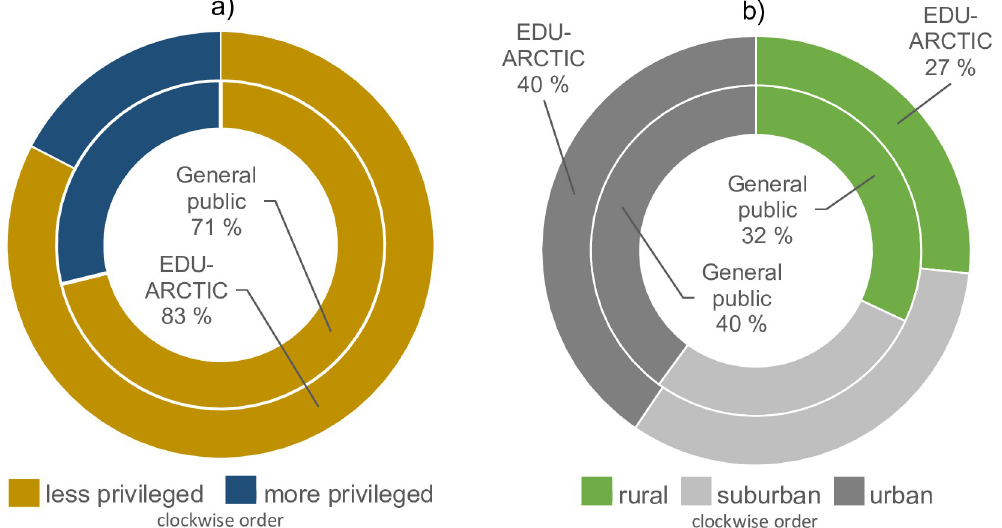
Fig 2. Proportion of less privileged groups among 1,176 teachers participating in the open online course EDU-ARCTIC (2016–2019) and among the general European population, according to a) country’s value on the United Nations in-equality adjusted Human Development Index (IHDI), from which we defined less privileged as below median for Europe (= 0.815). b) rurality of the teacher’s school, where we defined rural areas as < 300 people/km 2 , suburban as 300–1,500 people/km 2 and urban as > 1,500 people/km 2 ( sensu the Eurostat Regional Yearbook). Both a) and b) are based on individual teachers (some schools had > 1 teachers